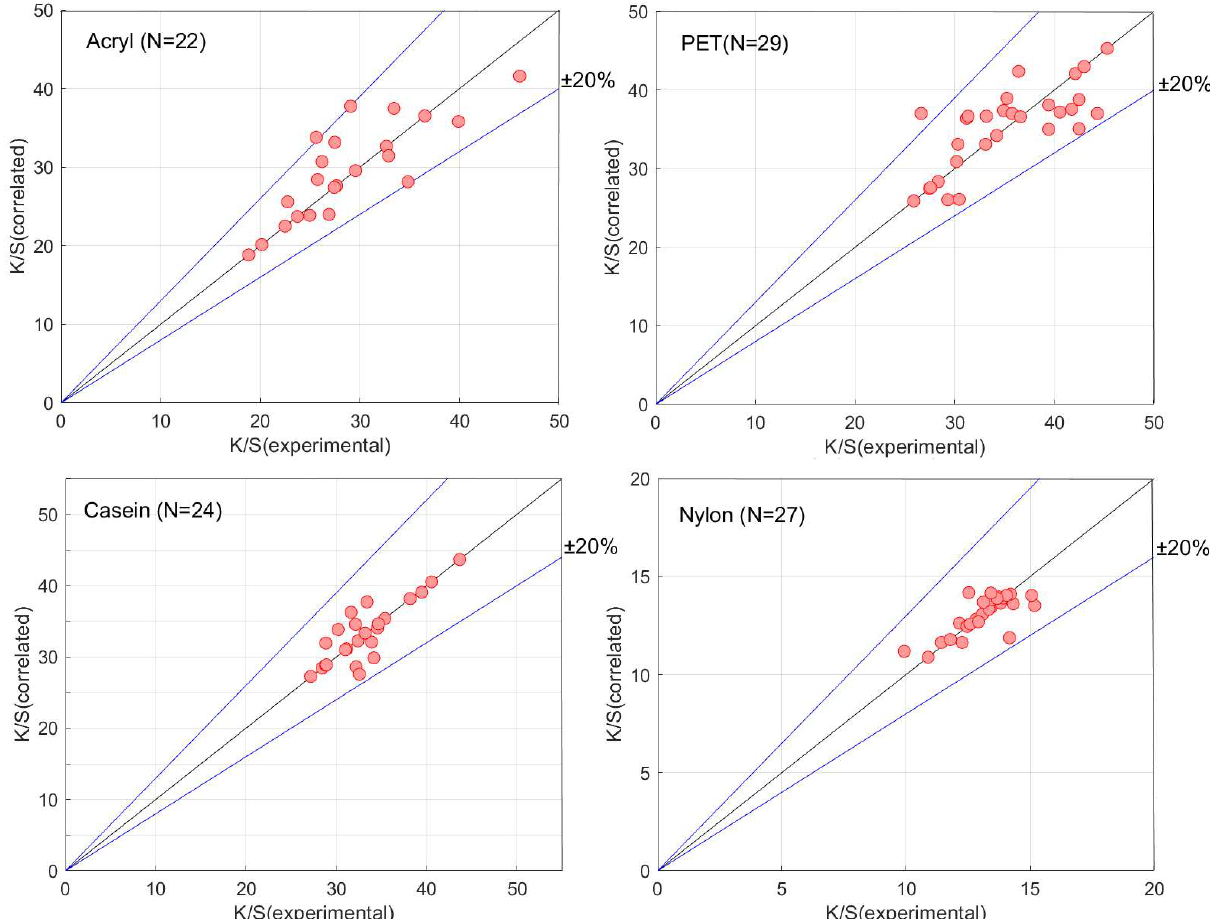
Dimensions of P , T , 𝜌 , and t used in the equation were expressed by MPa, °C, mol/m 3 , and min. Figure 6 compares the experimental results for each button with those calculated by the multiple regression parameters shown in Table 4. The blue solid lines indicate errors of the deviations between the experimental and calculated ones within +/− 20%. The experimental data of each button were indicated by red solid points. If the solid plots are on the diagonal line, the calculated results correspond to the experimental values.